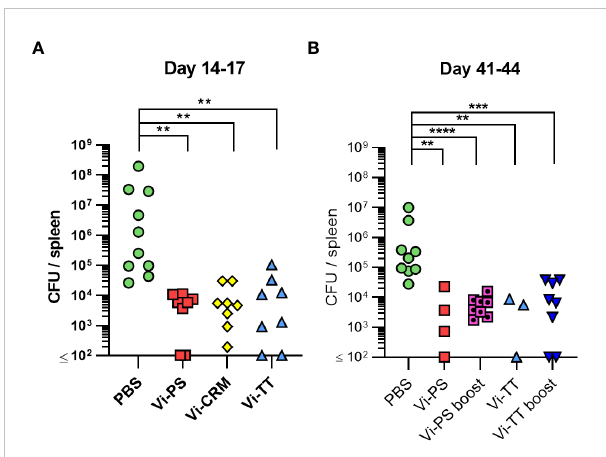
FIGURE 2 Vi-polysaccharide and Vi-conjugate vaccines provide equal protection against infection with Vi+ S. Typhimurium. (A) Colony forming units (CFU) in the spleen of C57Bl/6 mice immunized i.p with 2 µg Vi-PS, Vi-CRM 197 , Vi-TT or PBS mice, then infected for 72 hours with 1x10 5 CFU Vi+ S. Typhimurium TH177 14 days later. Data pooled from 2 experiments with n = 4 mice/group. (B) Spleen CFU of immunized i.p with either 4 µg of Vi-PS or Vi-TT at day 0, or 2 µg each vaccine at both day 0 and 35 (boost groups), then infected with 1x10 5 CFU TH177 day 41, for 72 hours. Data pooled from 2-3 experiments with n = 2 or 4 mice/group. *p ≤ 0.05, **p ≤ 0.01, ***p ≤ 0.005 and ****p ≤ 0.001 by Kruskall Wallace one-way ANOVA with Dunn ’ s multiple comparisons between groups